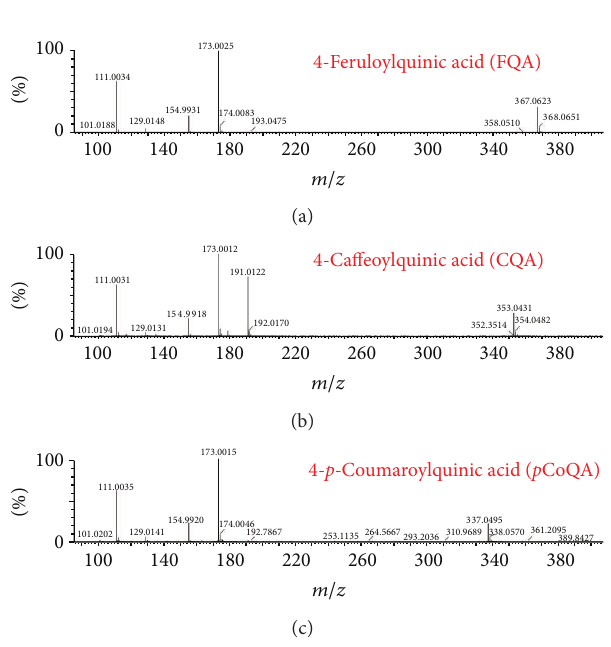
Figure 1: Mass spectra showing the fragmentation patterns of FQA (a), CQA (b) and p CoQA